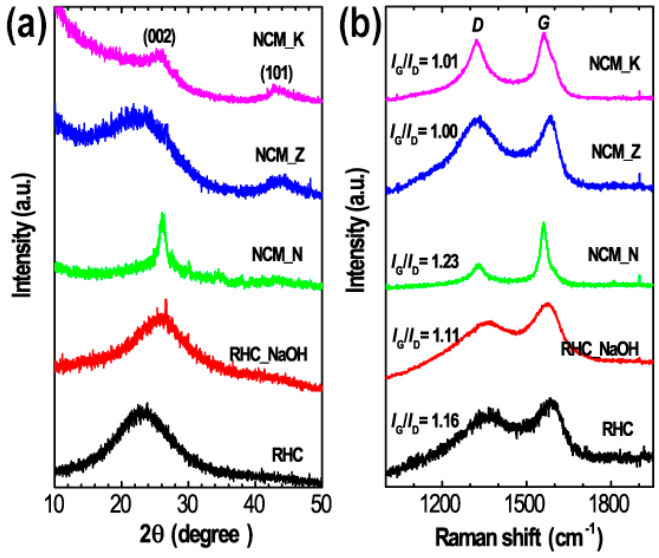
Figure 4. ( a ) pXRD patterns, and ( b ) Raman scattering spectra of RHC, RHC_NaOH, NCM_N, NCM_Z, and NCM_K recorded at 25